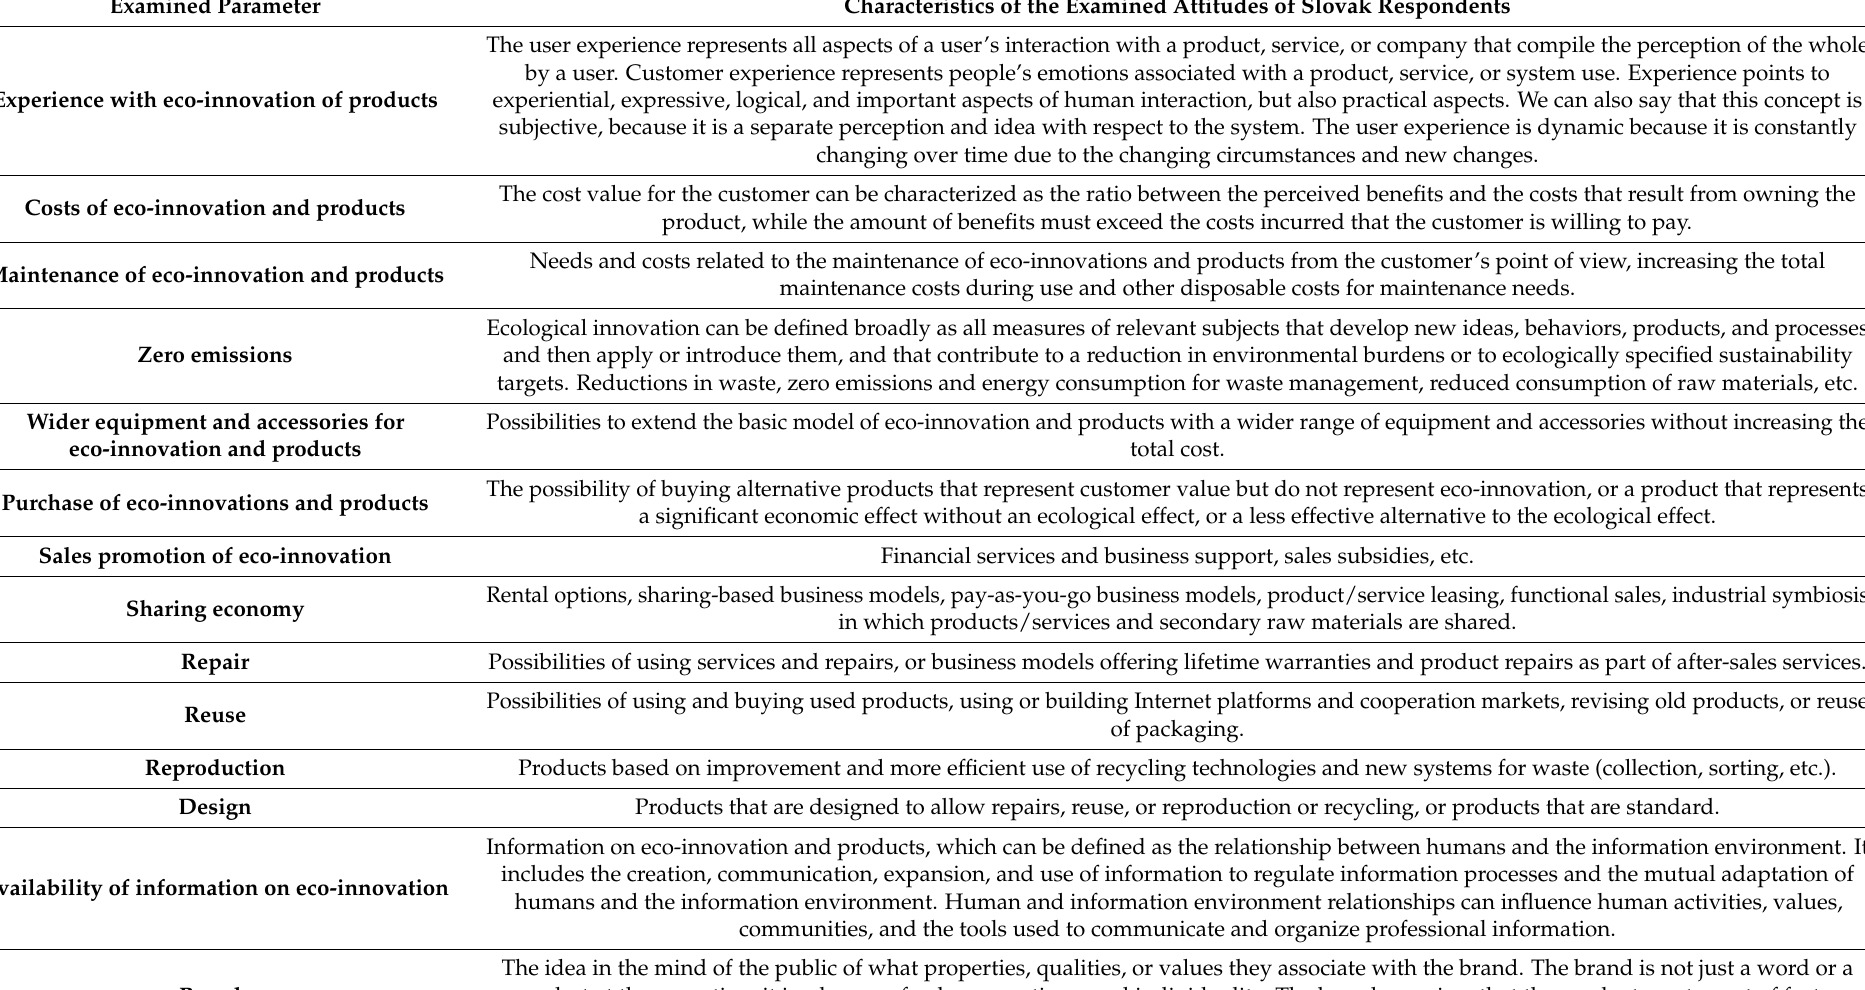
Table 1. Characteristics of researched attributes ([50,51] and